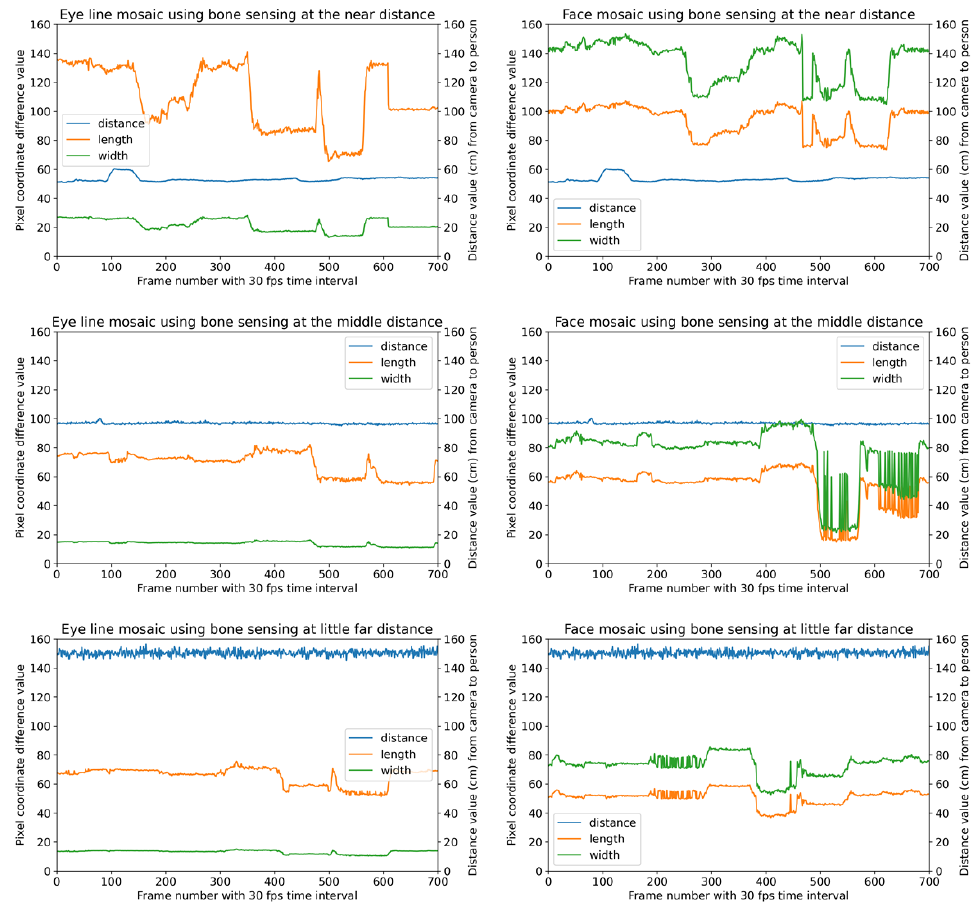
Figure 13. Facial masking results using image-based bone sensing in this